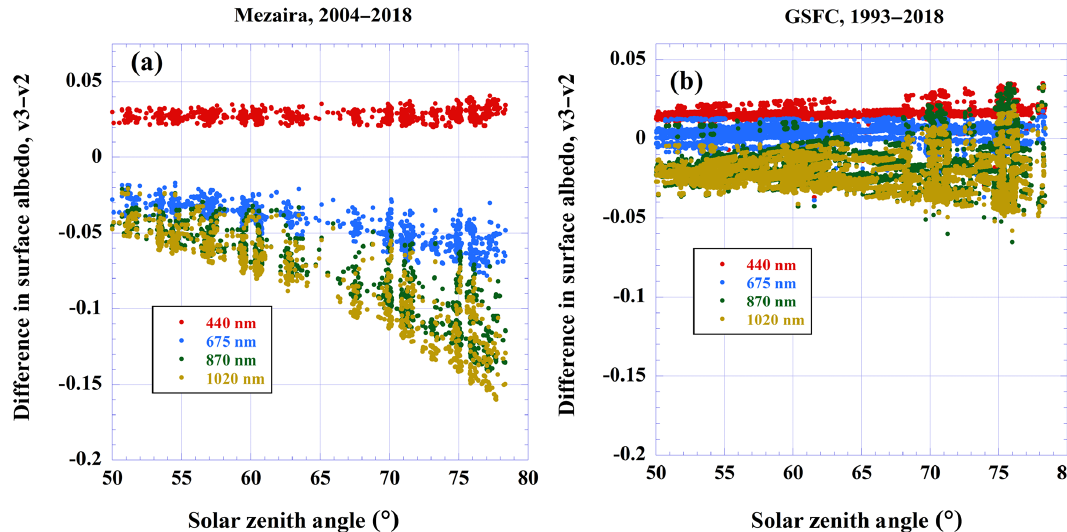
Figure 2. Difference in surface albedo calculated with BRDF from V2 and V3 for (a) Mezaira (2004–2018) and (b) GSFC (1993–2018).